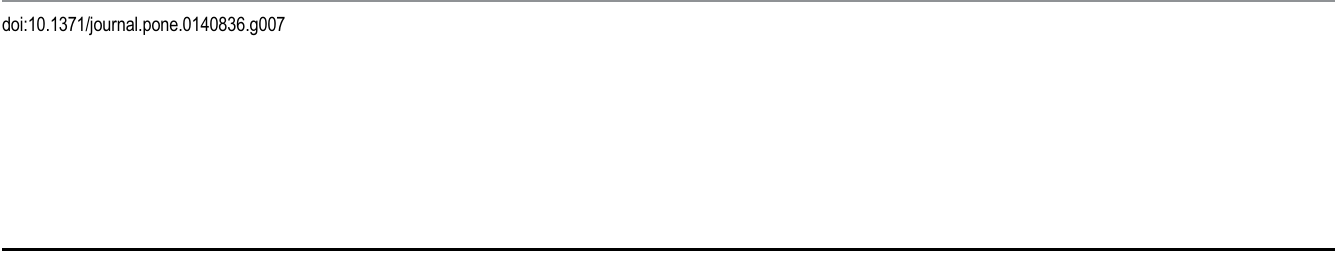
Fig 7. Results of the measurement experiments of the target total torque production task. (a) The blue circle indicates individual left, right and total elbow torques of all subjects. (b) The UCM component and the ORT component of all subjects. (c) The index of synergy of all subjects. The asterisk indicates a significant difference ( P < 0.05), and n.s. indicates a non-significant